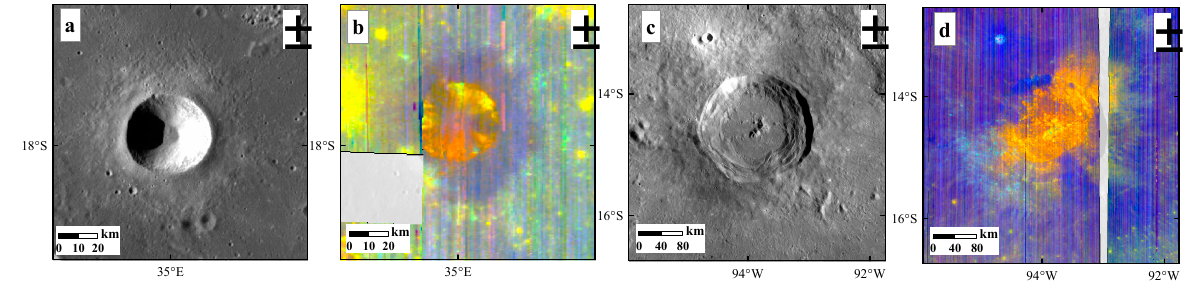
Figure 18. ( a ) Maunder crater in Orientale Basin; the base map is an LROC WAC image. ( b ) The M3 composite image displays the mineralogy of Maunder. ( c ) Rosse crater in Nectaris basin; the base map is an LROC WAC image. ( d ) The M3 composite image displays the mineralogy of Rosse. The lunar magma ocean (LMO) hypothesis suggests that as magma oceans begin to solidify, they first crystallize to form olivine, which, due to its higher density, sinks toward the bottom of the magma ocean as it crystallizes and differentiates [50,51]. The impact basin formation is responsible for the exposure of olivine. Large impact events could have penetrated and blasted away the lunar upper crust, excavating deep-seated